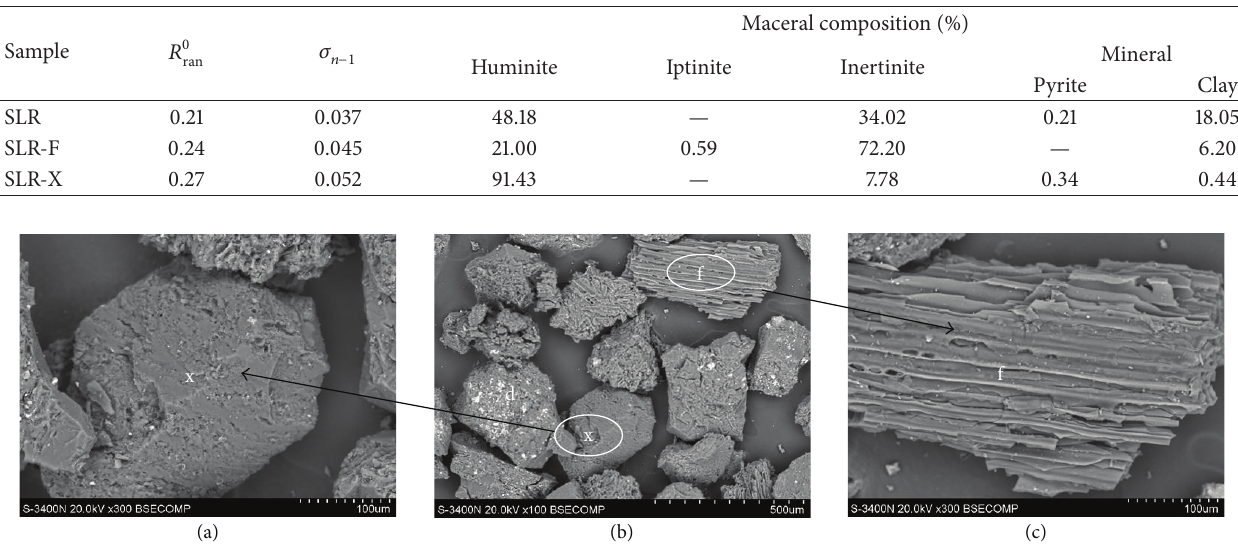
Committee for Coal and Organic Petrology (ICCP)